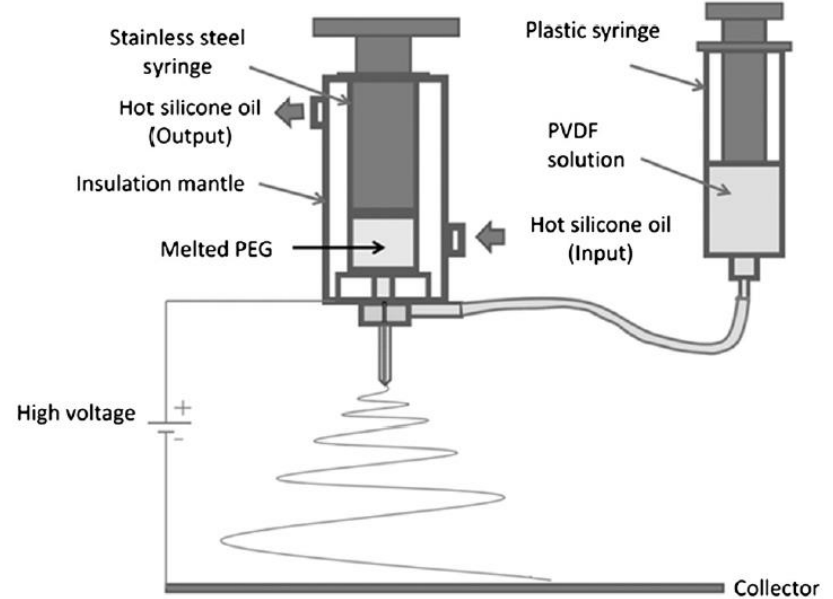
Figure 7. Schematic diagram of melt coaxial electrospinning [71].